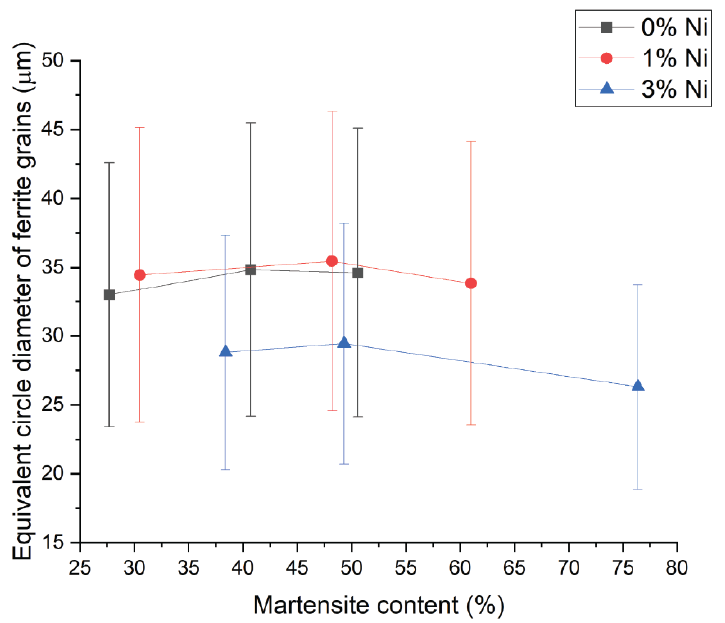
Figure 7. Ferrite grain size characterization by EBSD for varying content of martensite and Ni. Refining effect evident when increasing Ni content to 3-wt% Ni.